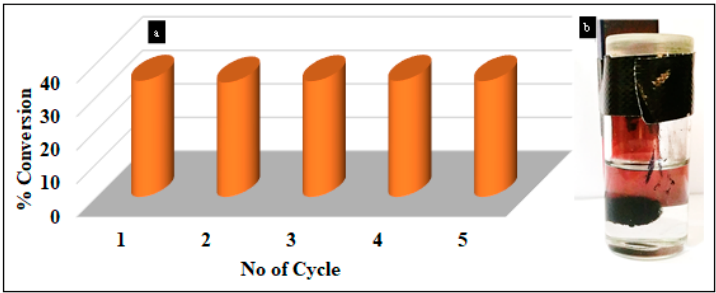
Figure 8. ( a ) Reuse of the catalyst, ( b ) separation of the catalyst from reaction medium. Conditions: